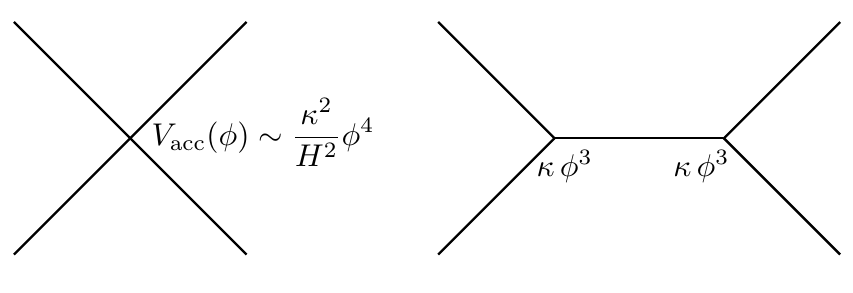
Figure 7 . We can include the e(cid:11)ect of the (cid:127) (cid:30) term in the equation of motion by an e(cid:11)ective vertex, V acc ( (cid:30) ), given in eq. (C.2). However, any diagram containing this vertex will be subleading to one using two insertions of the lagrangian interaction connected by a propagator, since the late time scaling of any graph is t P (cf. eq. (3.17)), where P is the total number of propagators. We